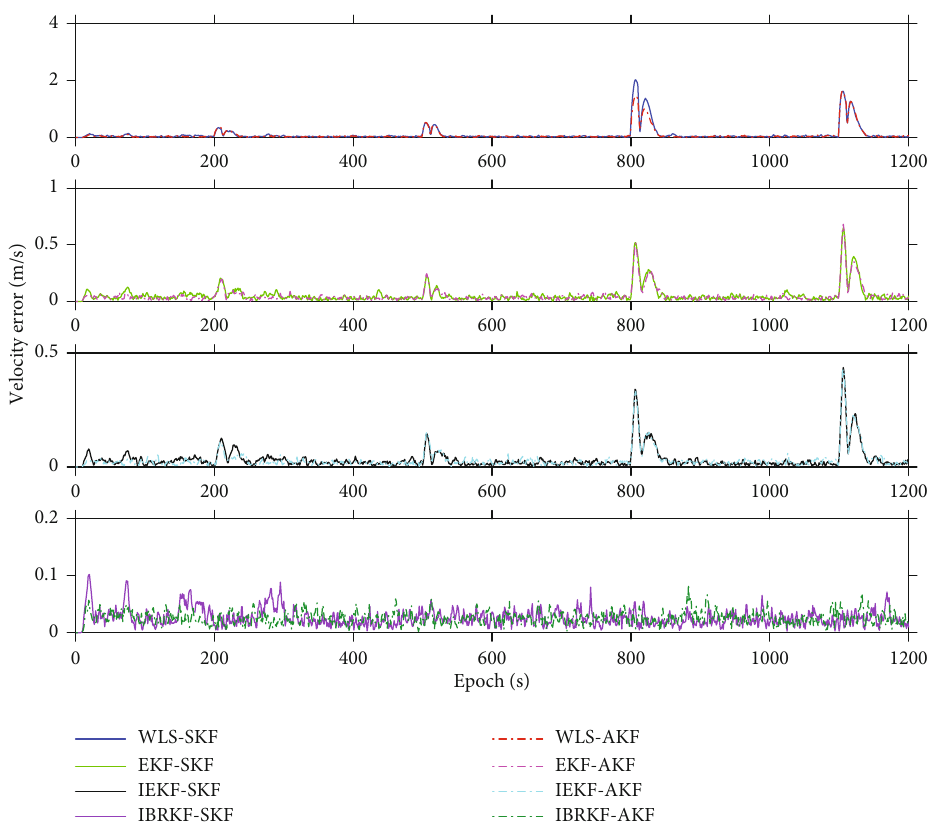
Figure 17: The velocity errors of various algorithms (Data